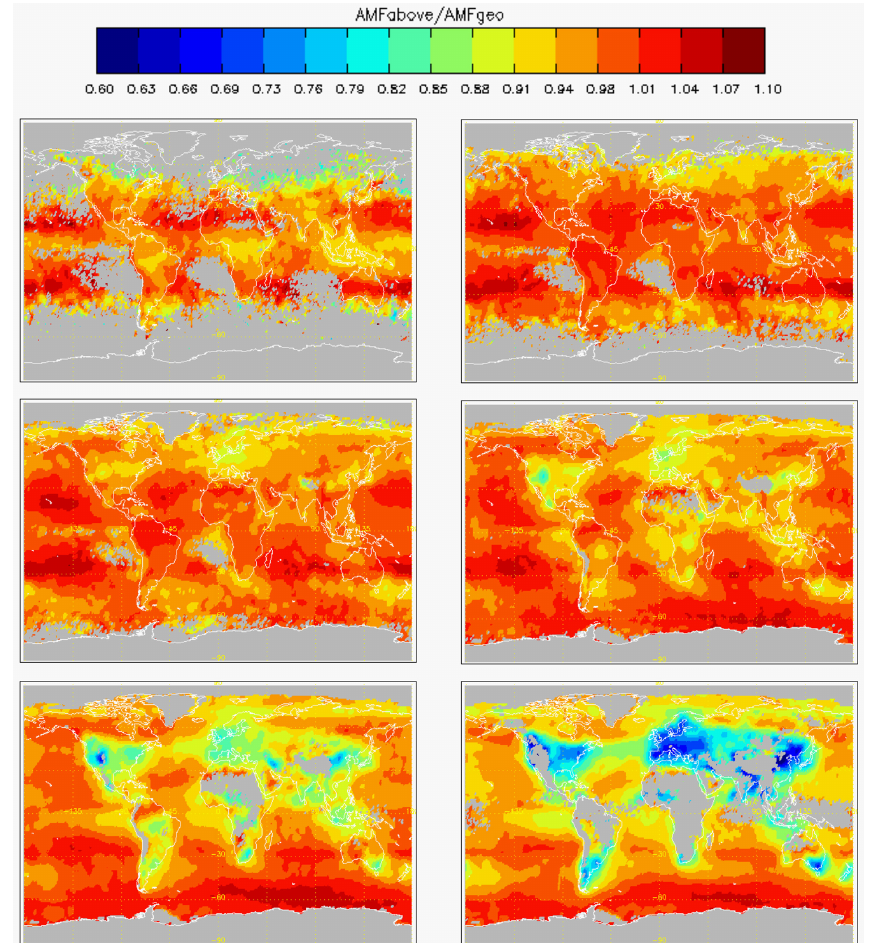
Figure 4. Tropospheric scattering sensitivities above cloud level (AMF above / AMF geo in Eq. 4): for high-altitude clouds (top row, 330 and 450hPa), mid-altitude clouds (middle row, 570 and 670hPa) and low clouds (bottom row, 770 and